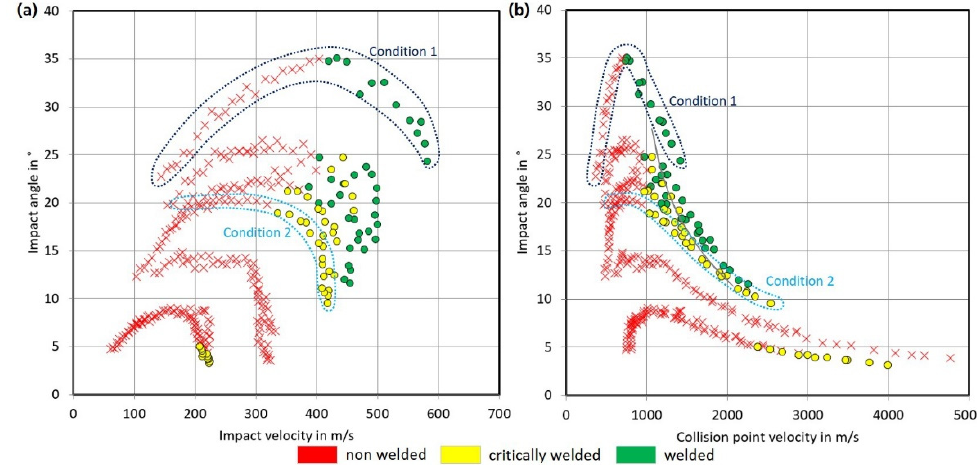
Figure 6. Identified process window for MPW of AA6016 T4 to 22MnB5 (hardened) ( a ) based on normal impact velocity v n and impact angle α , ( b ) based on collision point velocity v c and impact angle α . The dotted lines indicate the collision parameters of the high-quality (condition 1; dark blue line) and the critical weld (condition 2; light blue line). Table 3. Results of the lap shear test and resulting failure mode for Condition 1 and Condition 2.